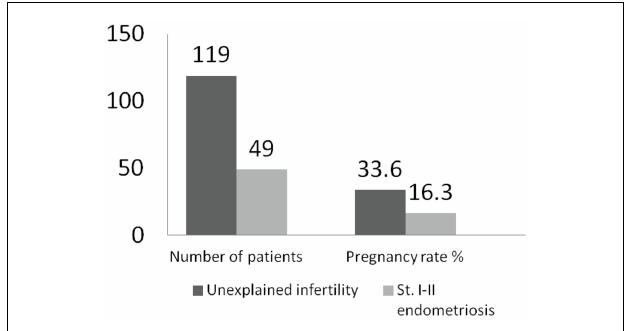
FIGURE 1 | Outcomes of COH–IUI in minimal or mild endometriosis (